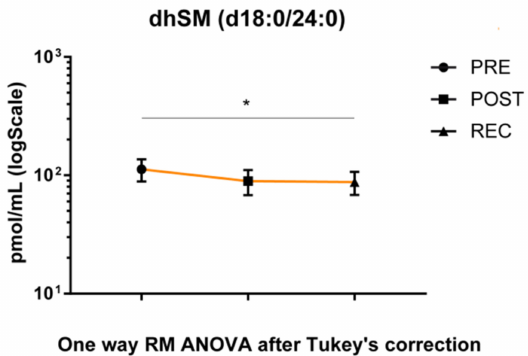
Figure 5. LC-MS analysis results for dhSM (d18:0/24:0) in serum of placebo-treated subjects. Results are expressed as pmol/mL in Log scale (PRE n. 10, POST n. 10, REC n. 10). p -value is indicated as: * p -value <